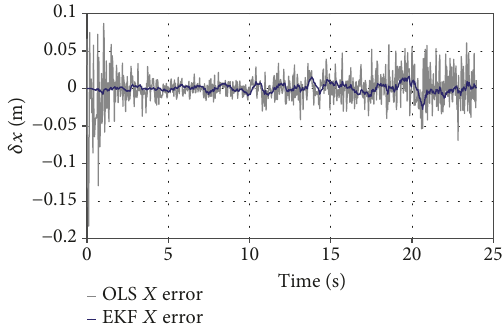
Figure 16: Error of estimation of horizontal component of wind.